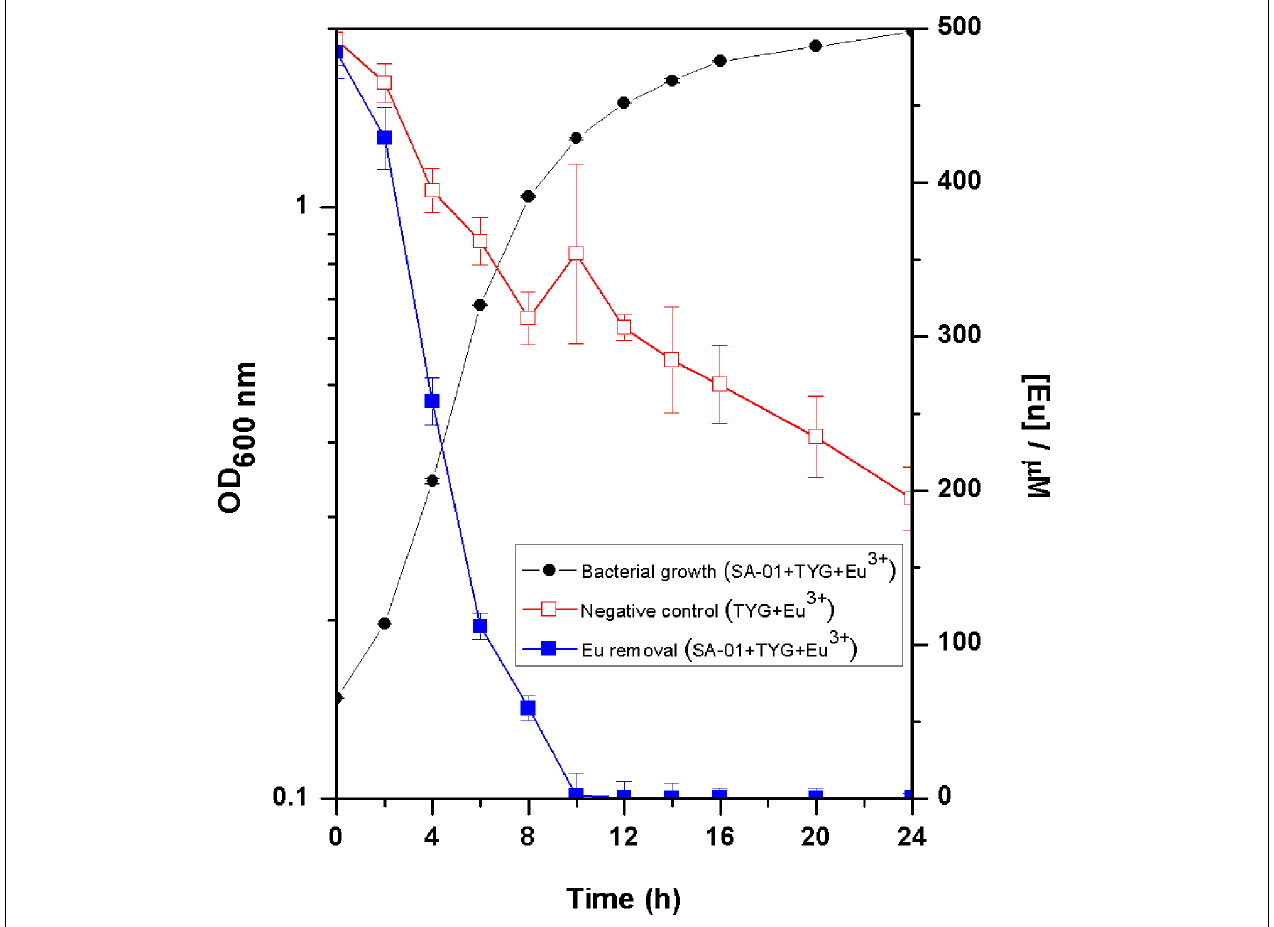
FIGURE 2 | Growth curve of T. scotoductus SA-01 supplemented with 0.5 mM Eu 3 + in TYG media. Error bars indicate standard deviation, while symbols indicate mean